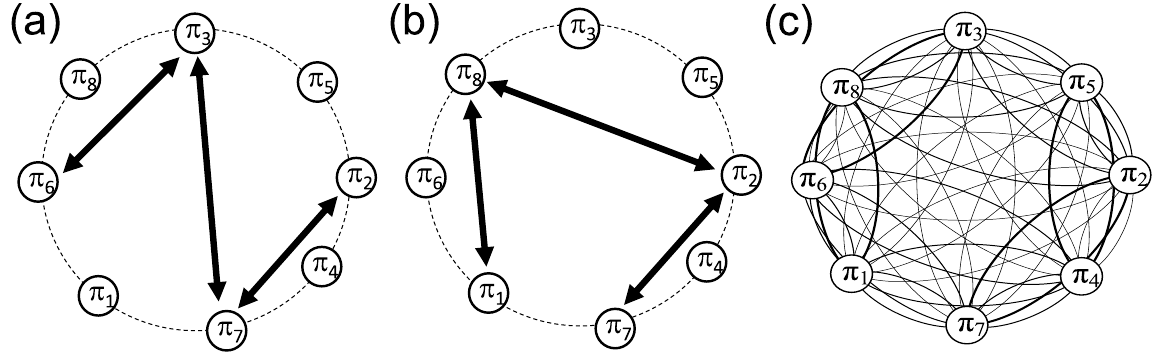
Figure 3. ( a ) Ordinal partition transition networks for periodic processes of Fig. 2(b), and respectively, ( b ) is for Fig. 2(c). Panel (c) corresponds to a 3D independent identical distributed random uniform noise where link arrows (bidirectional) are suppressed for the ease of visualization.